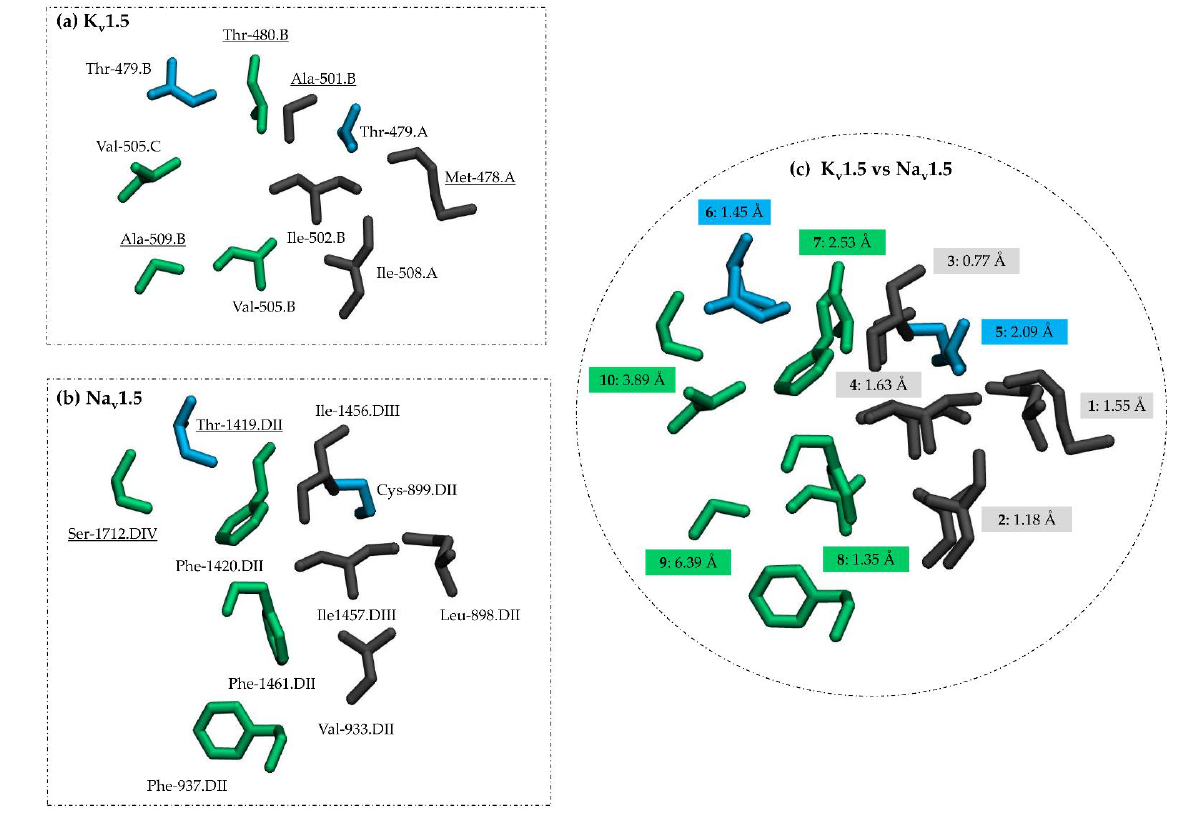
Figure 6. Structural alignment of equivalent residues in flecainide BS . The equivalent residues of flecainide BS in ( a ) K v 1.5, ( b ) Na v 1.5 and ( c ) their superposition according to PocketAlign comparison are displayed. Only residues with a contact frequency ≥ 70% are shown. In ( c ), the equivalences are numbered from 1 to 10 similar to Table 4. The underlined residues were not previously reported in flecainide BS. In addition, the distances between the centers of mass of the equivalent residues are appended. Table 4. List of equivalent residues in K v 1.5 and Na v 1.5 flecainide BS according to PocketAlign predictions . The structures used for comparison correspond to centroids K v 1.5_c2 and Na v 1.5_c2 . Only the residues with a frequency of contact ≥ 70% are considered. The asterisk indicates residues relevant for flecainide bindings as reported by mutagenesis in K v 1.5 and cryo-EM Na v 1.5-flecainide structure [20,21]. Residues were classified according to their PocketMatch physicochemical nature description in ( a ) aliphatic, non-polar and uncharged; ( b ) aliphatic, polar with hydroxy or mercapto group; ( c ) aromatic, uncharged amino acid. Type of interaction information comes from Figures 2b and 4b for K v 1.5 and Na v 1.5, respectively.